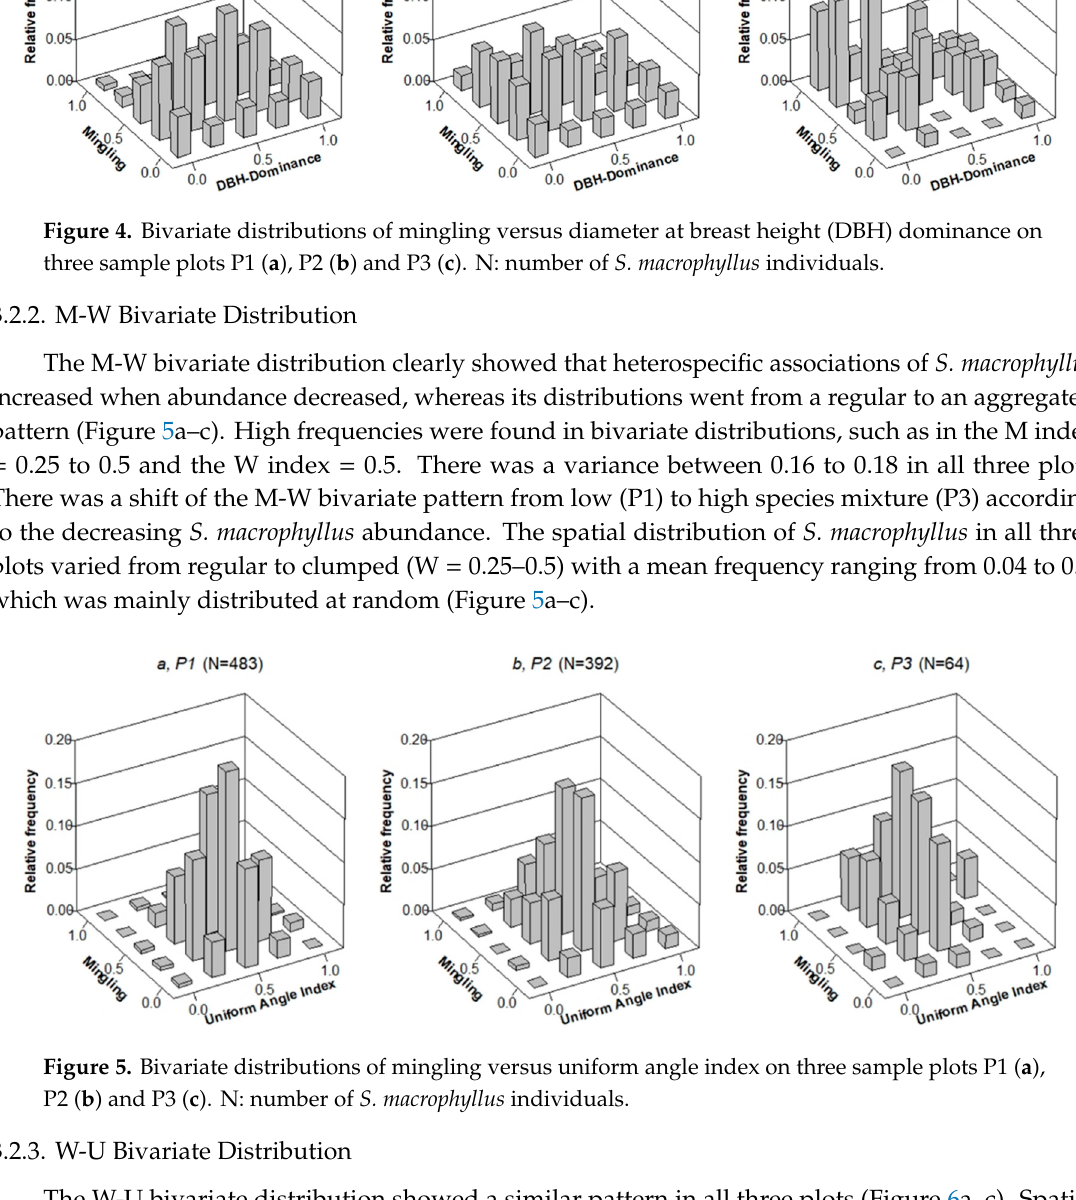
Figure 6. Bivariate distributions of the uniform angle index versus DBH dominance on three sample plots P1 ( a ), P2 ( b ) and P3 ( c ). N: number of S. macrophyllus individuals. 4. Discussion A fragmented landscape may form a mosaic of patches impacted by different disturbance intensities with heterogeneity in the vegetation structure. This could lead to patchiness in tree species composition because of different environmental conditions within patches that encourage different